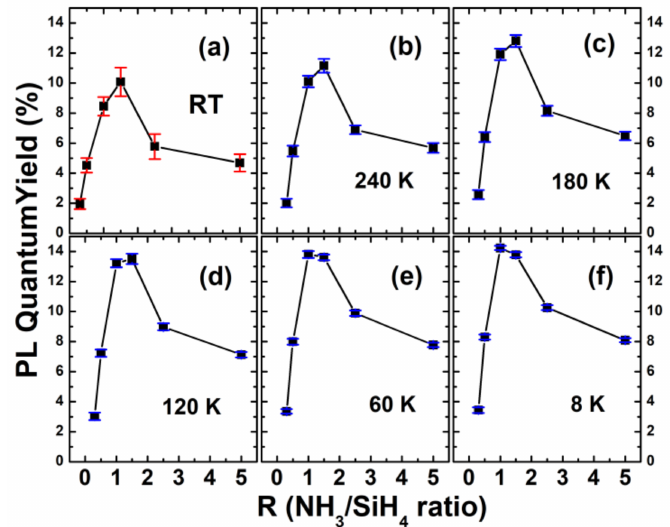
Figure 9. The PL QY of a-SiN x O y samples with various R under measurement temperatures of ( a ) RT; ( b ) 240 K; ( c ) 180 K; ( d ) 120 K; ( e ) 60 K; ( f ) 8 K. Red and blue lines show the error bars of the temperature-dependent PL QY